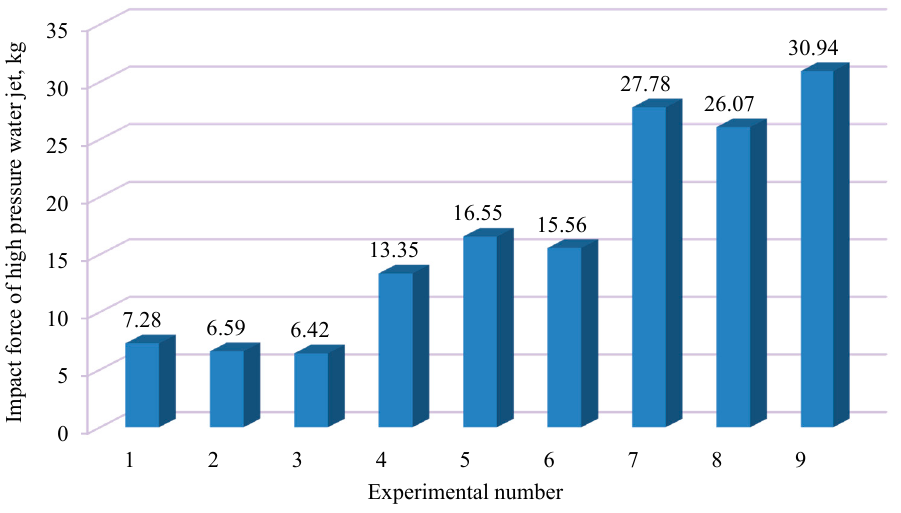
Figure 8. The impact force of the high-pressure water jet produced by the straight cone nozzles with different structures based on the orthogonal experimental design.